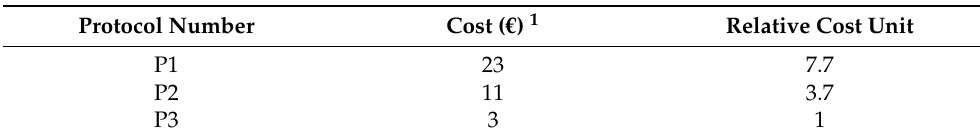
Table 2. Cost assessment for the processing of each sample with the different experimental protocols: protocol 1, P1; protocol 2, P2; protocol 3,